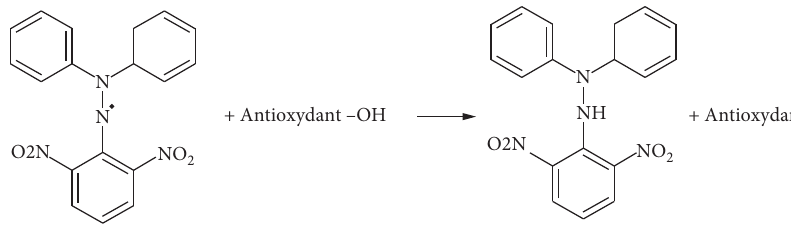
Figure 1: The reaction of an antioxidant with the radical DPPH.